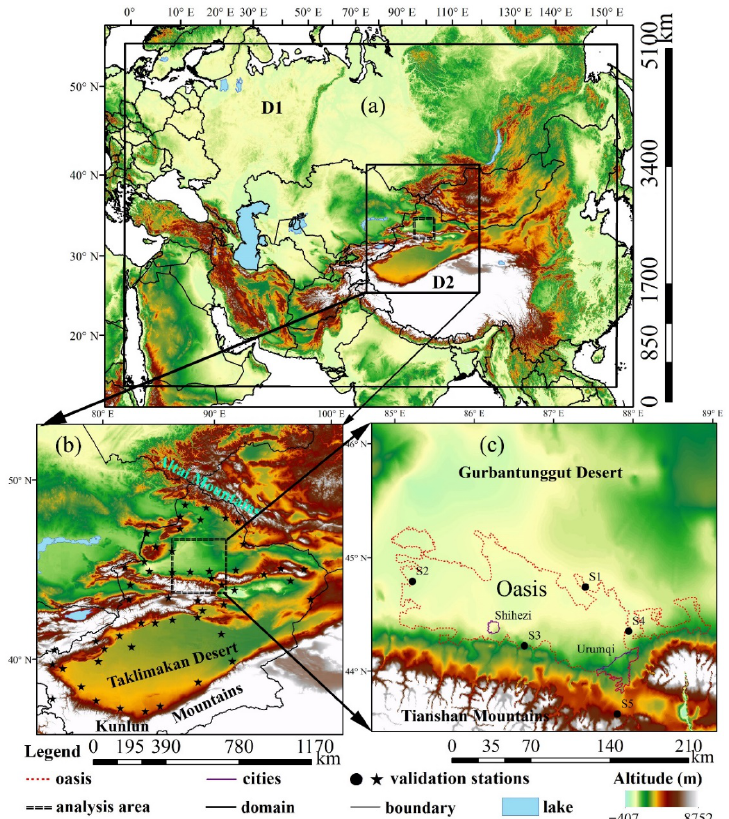
Figure 1. The two-nested ALARO modeling domains, D1 and D2 ( a ), and the locations of the meteorological stations in Xinjiang province ( b ) and the study area ( c ). The shaded contour represents topography; the validation stations in ( b , c ) are national (climatological) and automatic weather stations, respectively. The red dotted and black lines in ( c ) represent the boundary of oasis and cities, respectively.